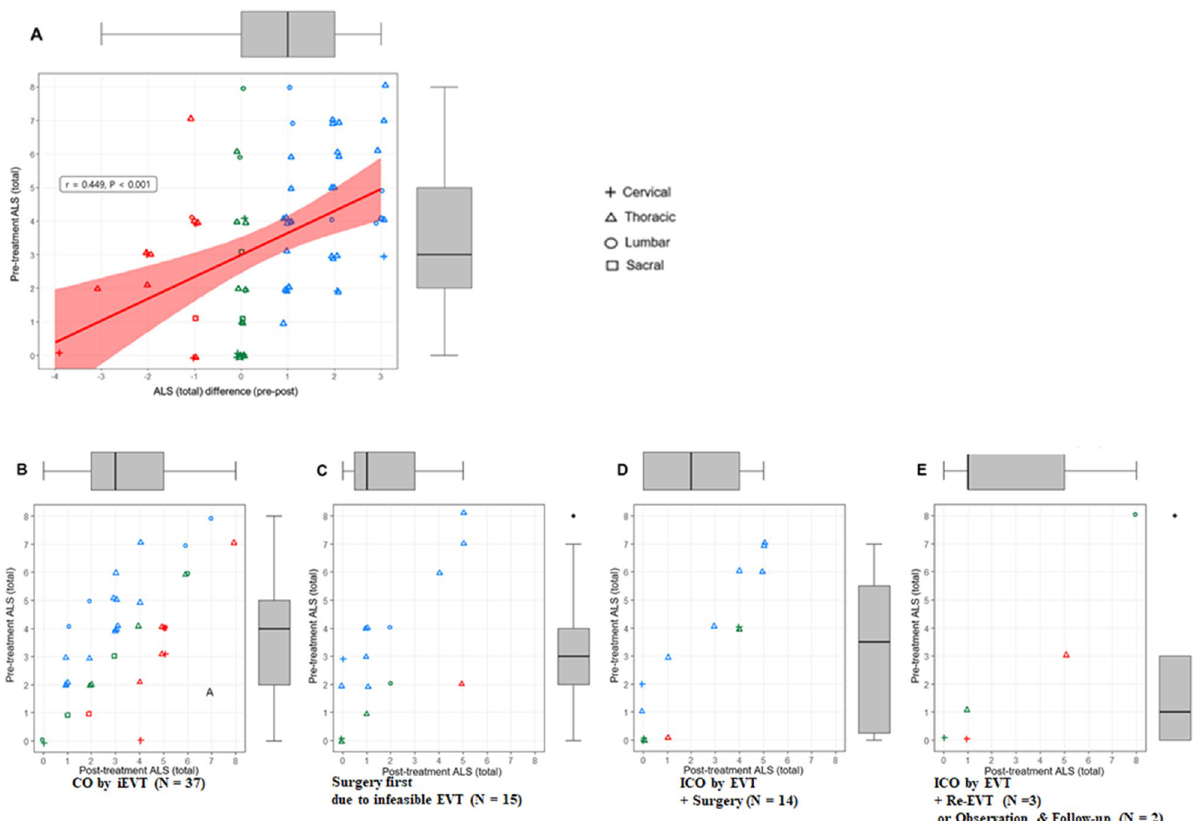
Figure 3. Comparison and distribution of pretreatment and posttreatment ALS scores of 71 patients with spinal dural arteriovenous fistula. ( A ) Scatter plots of the pretreatment ALS (total) versus ALS difference between pre- and post-treatment in 71 patients. r represents Spearman’s rank correlation coefficient. ( B – E ) Scatter plots of pre- versus post-treatment ALS (total) values among patients who underwent different treatment courses. Blue dots denote improved functional outcomes; green dots denote stationary functional outcomes; red dots denote worsened outcomes. ALS Aminoff-Logue scale; SDAVF spinal dural arteriovenous fistula; EVT endovascular treatment; ALS Aminoff-Logue scale; CO complete occlusion; iEVT initial EVT; ICO incomplete occlusion; Re-EVT repeated EVT; FU